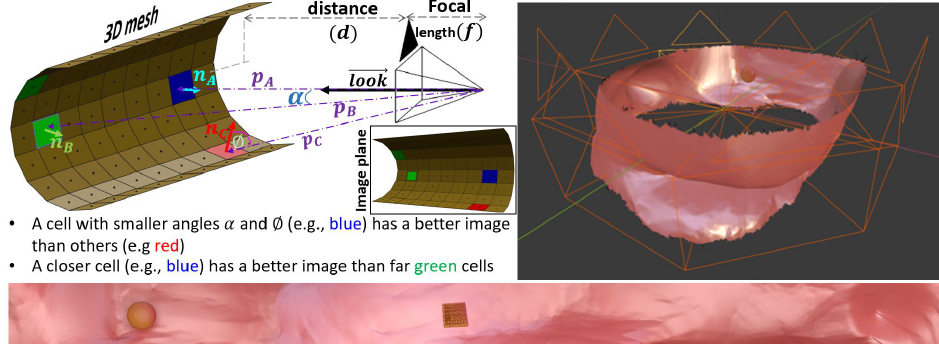
Figure 3. Visualization of colon segment via FI. ( Left ) Camera geometry showing that the cell −→ look , projection direction p , surface normal n , and distance d ; visualization depends on: principal axis ( right ) Cameras configuration of a rig of 8 cameras over a ring, and ( bottom ) the rendered filet.